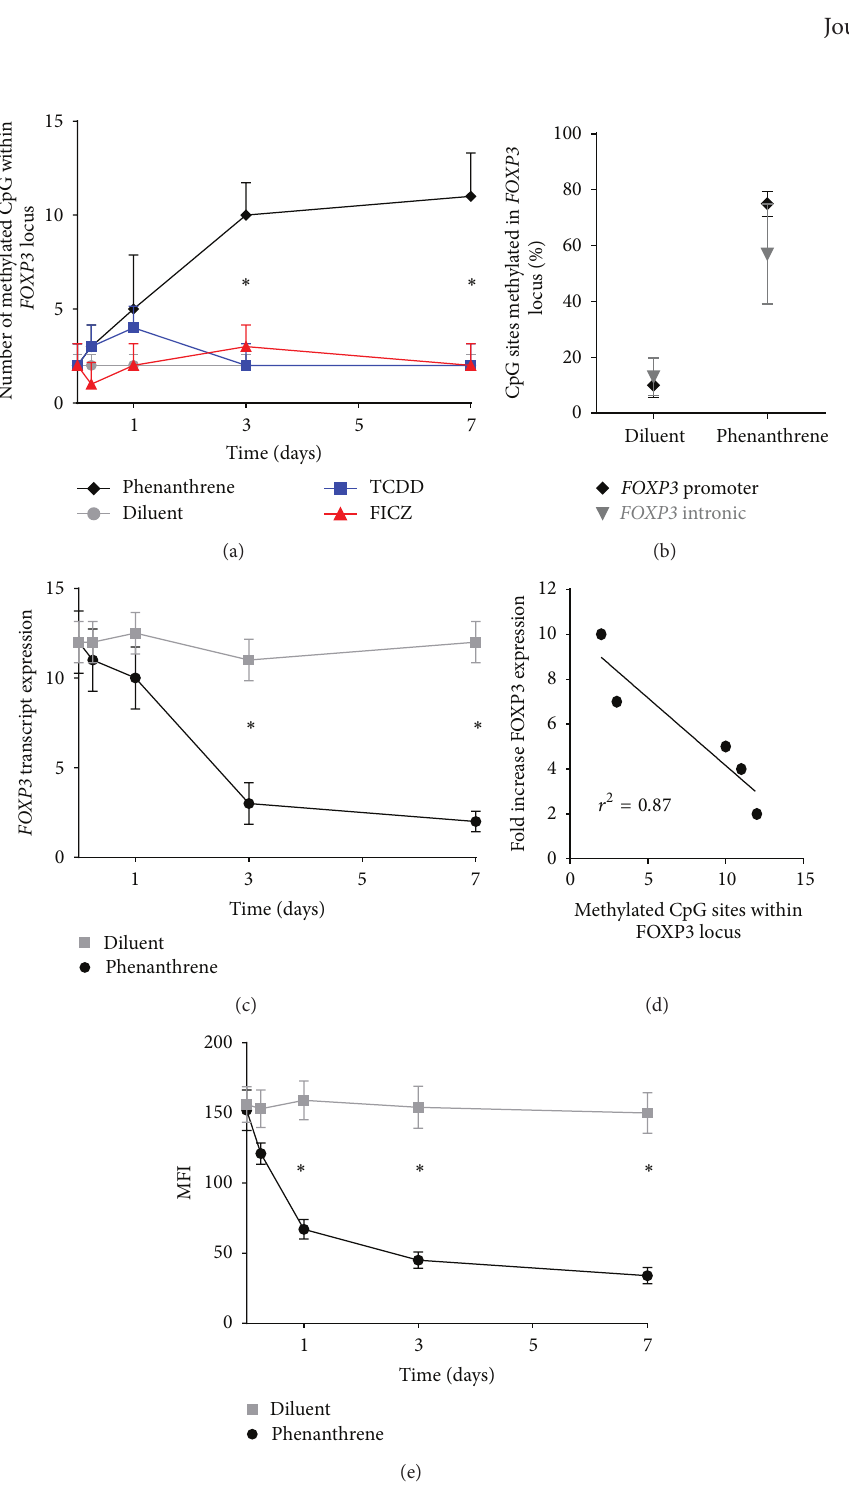
Figure 1: Phenanthrene exposure increases CpG methylation and reduces FOXP3 expression in primary Treg. Purified CD4 + CD25 hi CD127 lo FOXP3+TregfromPBMCofhealthydonors( 𝑛 = 5 )wereincubatedwith300 nMPhe(black),TCDD(blue),FICZ(red),ordiluent(grey)for0 to7days.(a)QuantificationofmethylatedCpGsites(outof13totalpromotorandintronicsites)withintheFOXP3locusoverthe7-dayculture. (b) After a 2-day incubation with Phe, DNA was analyzed for percentage of methylated CpG sites within promoter (black square, 𝑛 = 6 ) and intronic (gray triangle, 𝑛 = 7 ) sequences of the FOXP3 locus. (c) FOXP3 transcripts were quantified with QT-PCR and normalized to the housekeeping gene 𝛽 -glucuronidase . (d) Linear regression analysis of FOXP3 transcript expression to the number of methylated CpG sites within the FOXP3 locus; 𝑟 = Spearman’s correlation coefficient. (e) Intracellular FOXP3 protein expression was measured by flow cytometry and reported as median fluorescence intensity (MFI). ∗ 𝑃 < 0.05 ; error bars represent